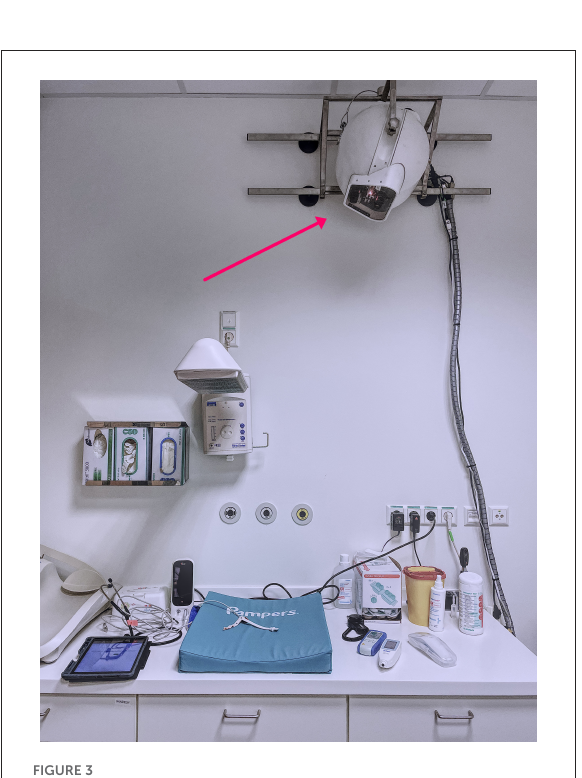
FIGURE3 Camera-based sensor at the maternity ward, fixed to standard issue clinical wall